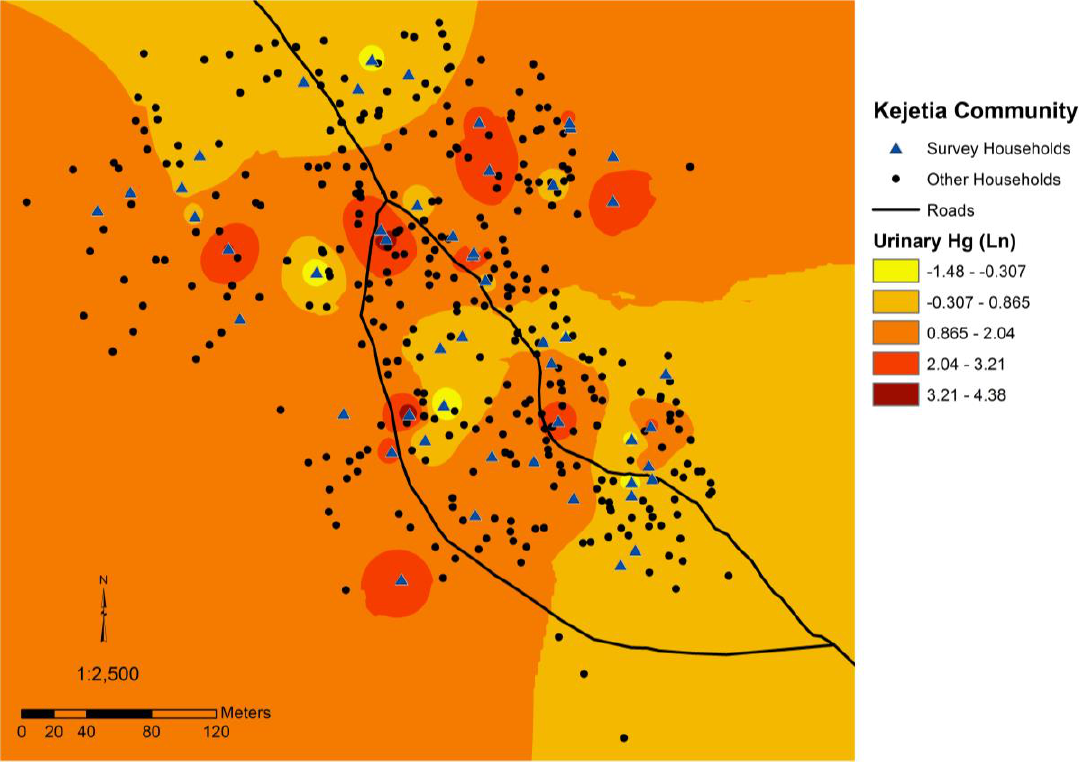
Figure 6. Map of Kejetia including an estimation of mean urinary Hg (log-transformed) throughout the community. Darker red indicates higher estimated urinary Hg concentrations for residents based on household